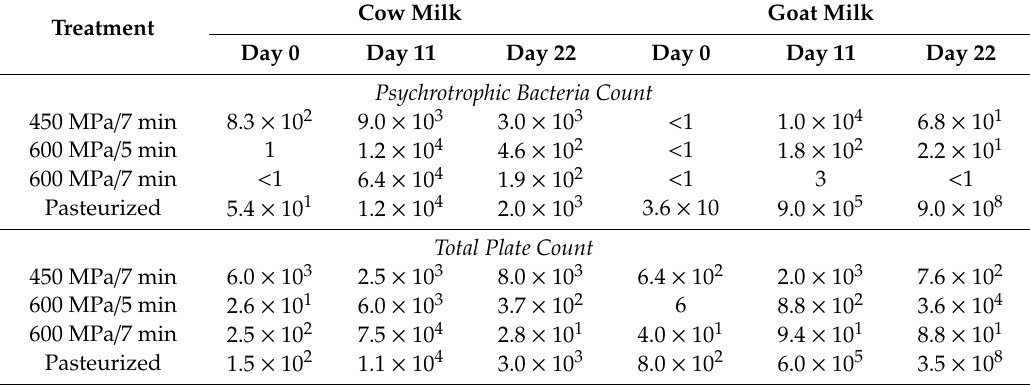
Figure 7. Changes in solid-non-fat of ( a ) cow and ( b ) goat milk during storage period of 22 days. Solid lines represent HPP-treated milk (450 MPa/7 min, 600 MPa/5 min, 600 MPa/7 min), dashed lines represent pasteurized milk, and dotted lines represent fresh milk before treatment. Table 3. Psychrotrophic bacteria count and total plate count (CFU / mL) in milk for 22 days of storage. Cow Treatment